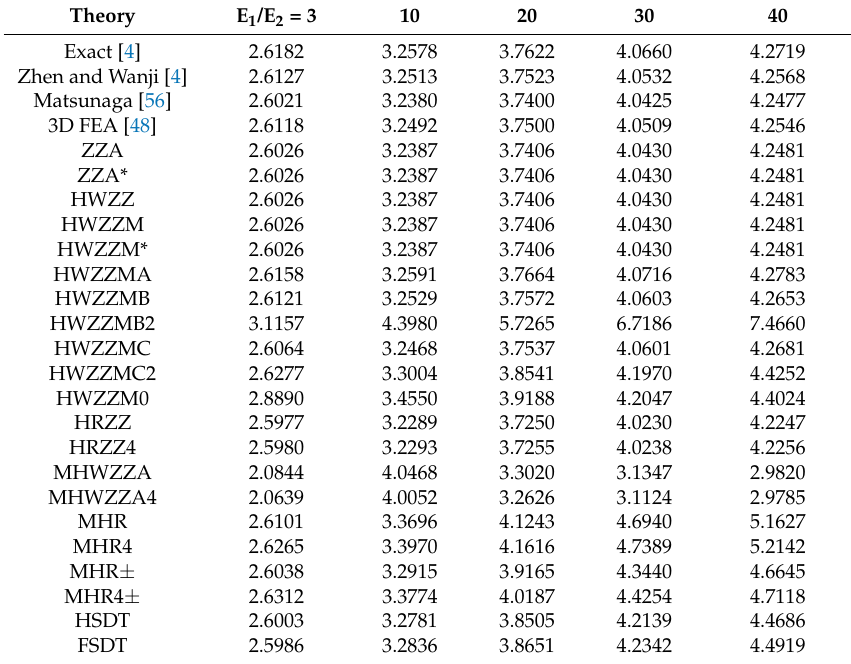
Table 8. Normalized fundamental frequencies, case